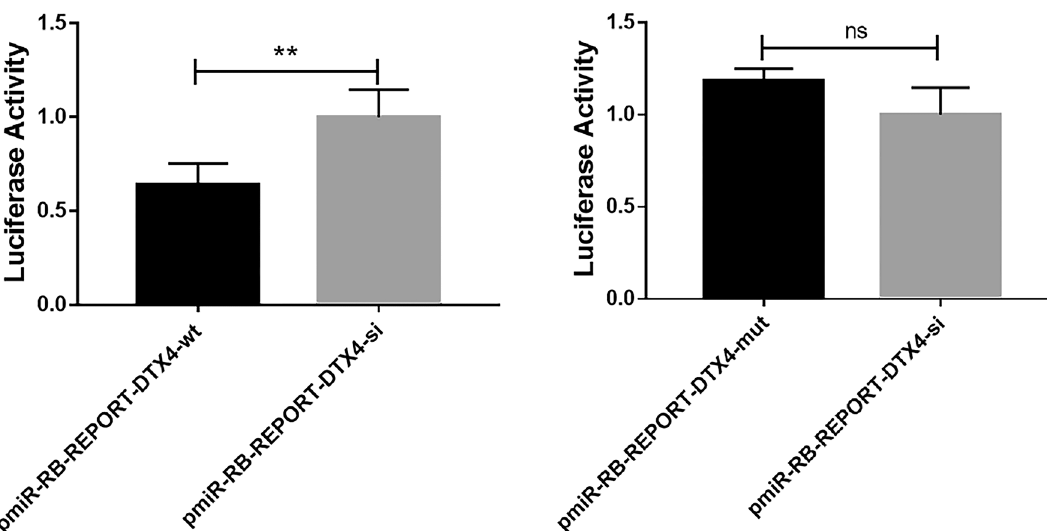
Figure 5. Dual-luciferase activity analysis showing the relative expression of miR-485 and genes after the co-transfection of miR-485 mimics and DTX4 -wt, miR-485 mimics and DTX4 -mut, and miR-485 mimics and DTX4 -si in bMECs (* P < 0.05, ** P < 0.01; ns means P >